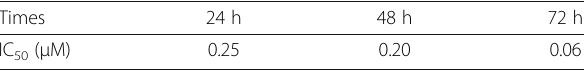
Table 1 50% inhibitory concentration (IC 50 ) of mitoxantrone in nano-drug preparations at various times